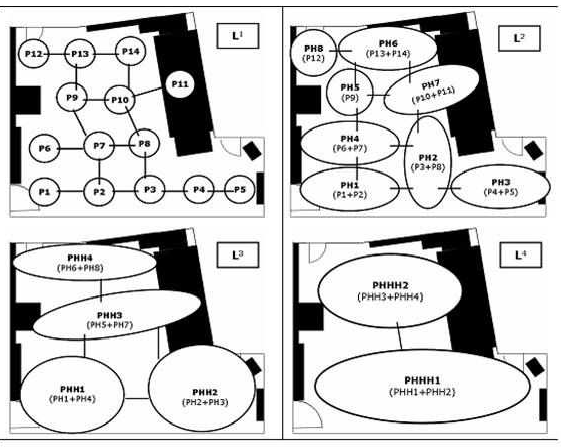
Fig. 5. Abstracted world model of Intelligent Sweet